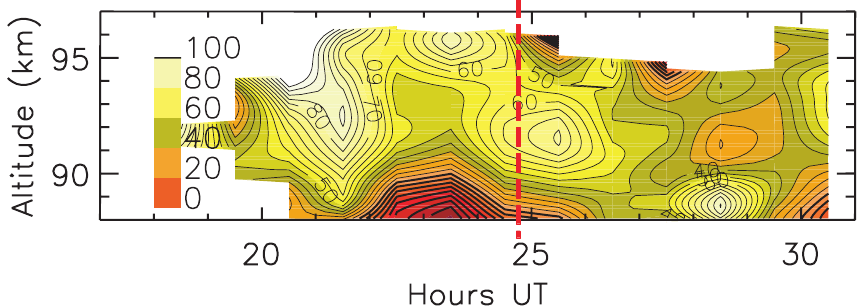
Fig. 2. Observed zonal winds during the night of 4/5 July, 2002. The vertical red line indicates the time of the launch of the large instrumented